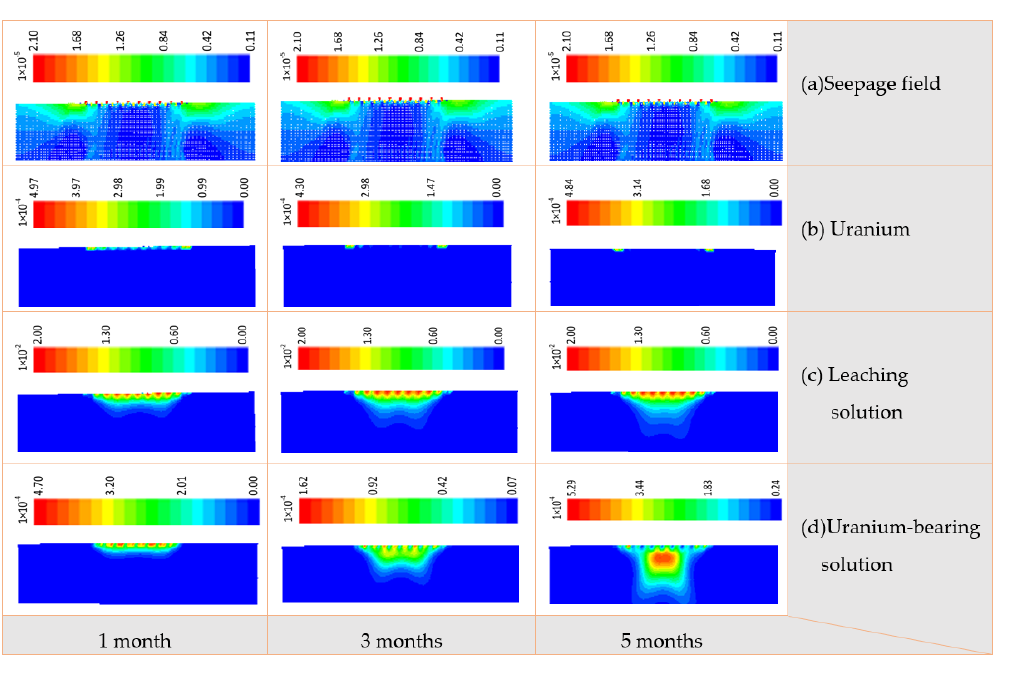
Figure 8. Multifield coupling evolution in the mining face ventilation, (a)Seepage field; (b) Uranium; (c) Leaching solution; (d) Uranium-bearing solution.